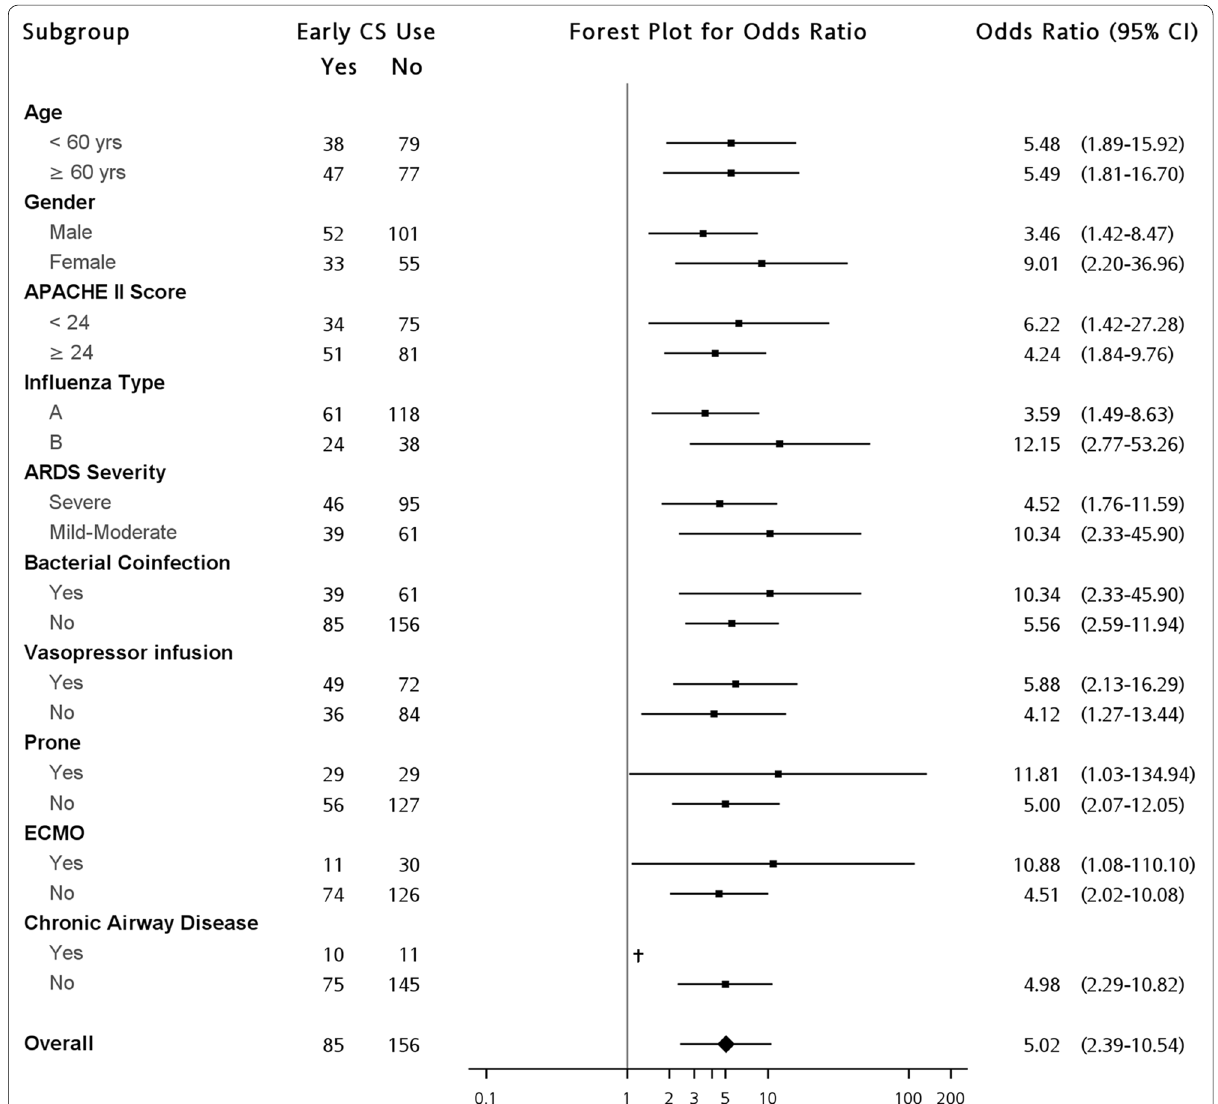
Fig. 3 Forest plot of stratified analyses showing adjusted odds ratio of early corticosteroid treatment. The subgroups were classified by demographic and disease characteristics. Odds ratios for mortality were adjusted for APACHE II score, underlying malignancy, influenza type, and ECMO treatment, which were selected from the multivariable model in Table 2. † The adjusted OR could not be calculated due to small sample